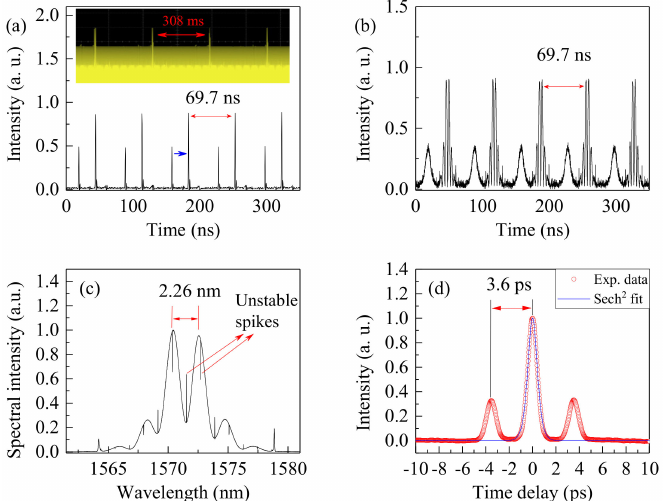
Figure 3. Repeated collisions between a soliton molecule and a soliton singlet. ( a ) Pulse train (inset shows the pulse train with a large scanning range), ( b ) the corresponding pulse train after DFT, ( c ) OSA-measured optical spectrum, and ( d ) autocorrelation